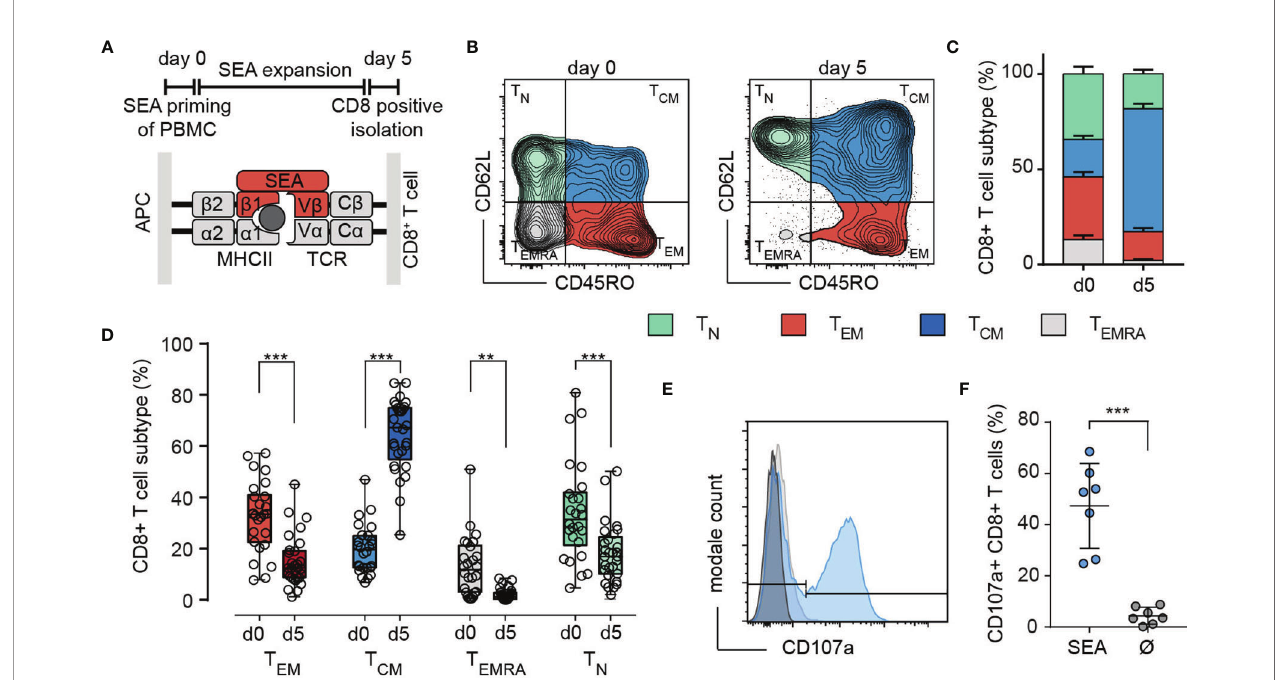
FIGURE 1 | SEA stimulation induces differentiation mainly into a T CM subtype. (A) Scheme of the 5-day stimulation with SEA (Staphylococcal enterotoxin A) and the mechanism of CTL-target cell crosslinking by the SEA molecule. (B) Representative example for gating of (CD3 + /CD8 + ) CTL into T N (CD62L + /CD45RO - ), T CM (CD62L + /CD45RO + ), T EM (CD62L - /CD45RO + ) and T EMRA (CD62L - /CD45RO - ) on day 0 and day 5 of SEA-stimulation. (C, D) n= 26-29 donors. (C) Quanti fi cation of subtype distribution at day 0 and day 5. Data are presented as mean+SEM. (D) Compared frequencies of T N , T CM , T EM and T EMRA on day 0 and day 5. Box and Whisker plots show min, max, median, and 25-75% interquartile range. Statistical analysis was done by a two-way ANOVA. (E, F) Detection of SEA-dependent degranulation by CD107a surface expression of SEA-CTL after co-incubation with SEA-pulsed Raji cells. (E) Degranulation of cells from a representative donor (-SEA: grey, +SEA: blue. F ) Quanti fi cation of (E) with SEA-loaded (SEA) and control (no SEA, Ø) target cells. Data are shown as mean ± SD of 7 donors. **p<0.01;